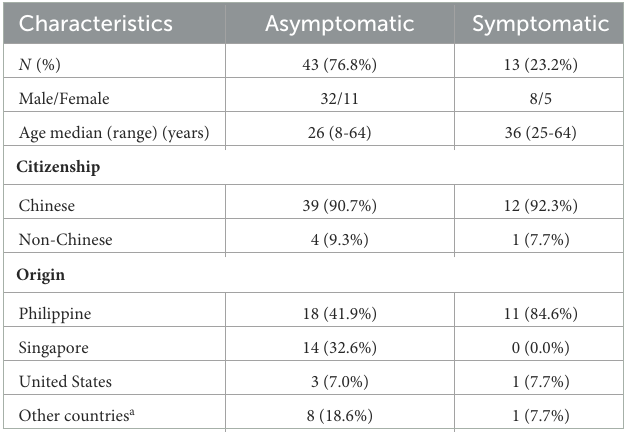
TABLE 2 Characteristics of 56 SARS-CoV-2